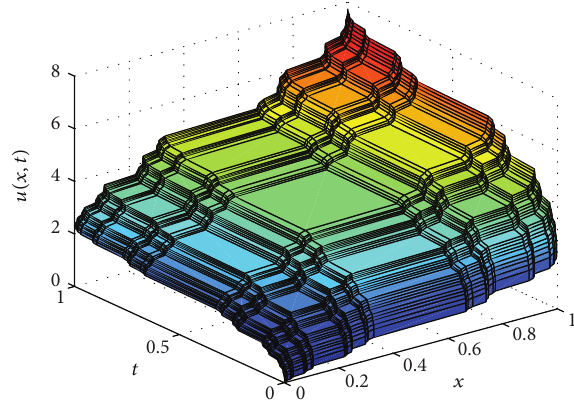
Figure 3: The plot of 𝑢(𝑥,𝑡) for the parameter 𝛼 = ln 2/ ln 3 .